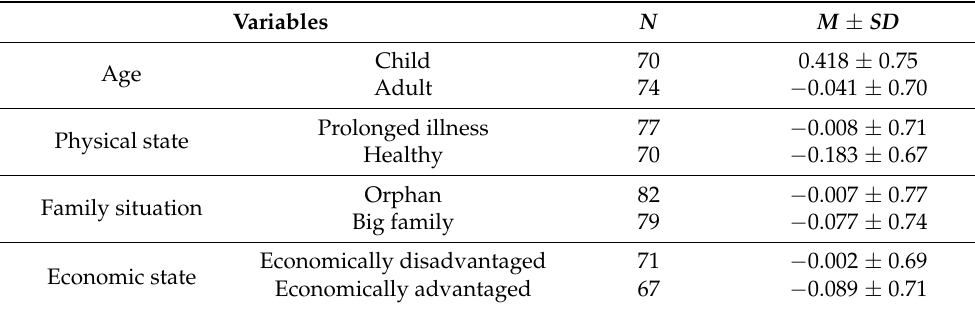
Table 3. Descriptive statistics of the average z-score for the figure, story, and idea tasks by the eight creator’s situations.